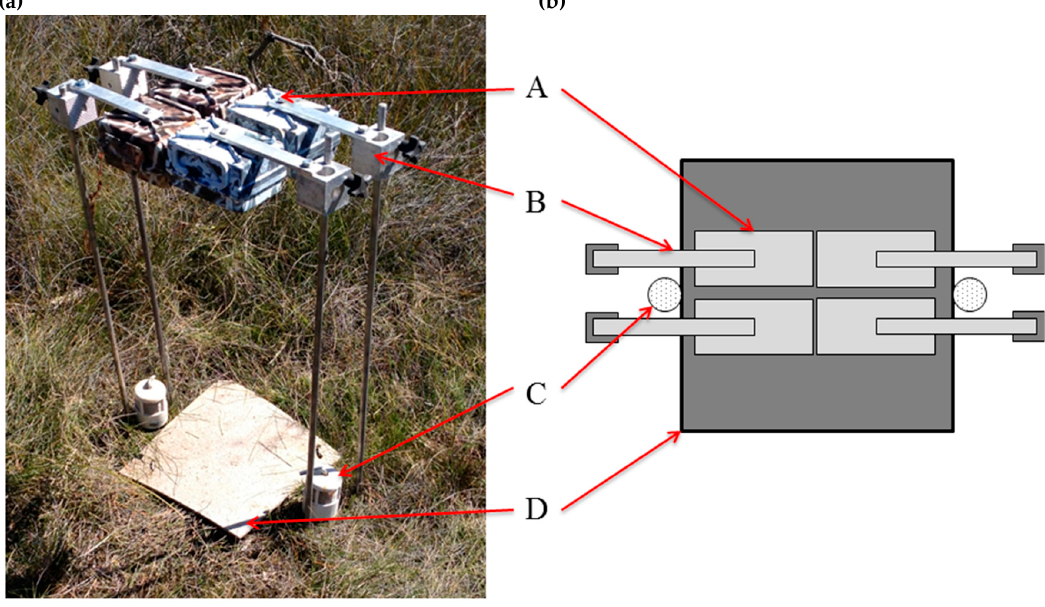
Figure 2. Panel ( a ) photo and ( b ) plan view of camera-trap station setup used to test focal length and passive infrared (PIR) sensor sensitivity. Two camera-traps are modified Reconyx PC900 models and two are standard Reconyx HC600 models. The setup includes: A, camera-trap; B, mounting assembly; C, bait holder baited with peanut butter and oats; and D, cork floor tile.